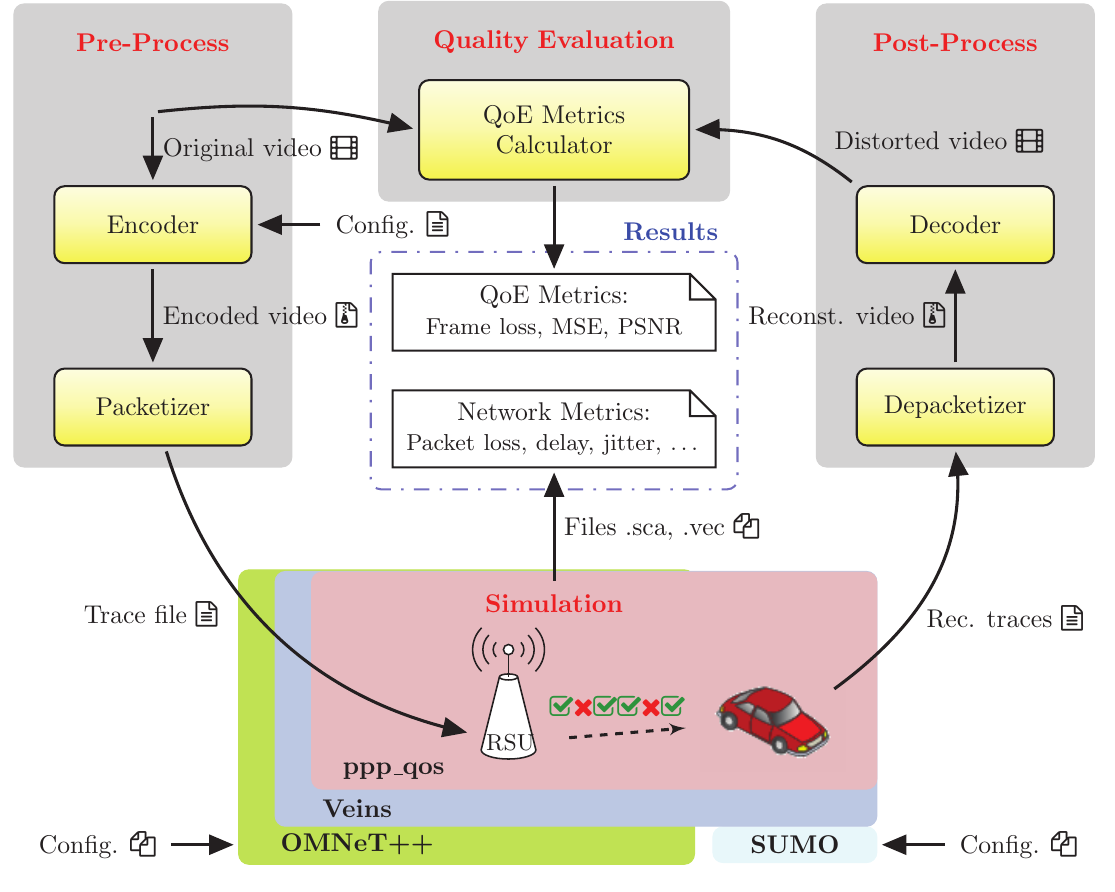
Figure 1. Workflow of